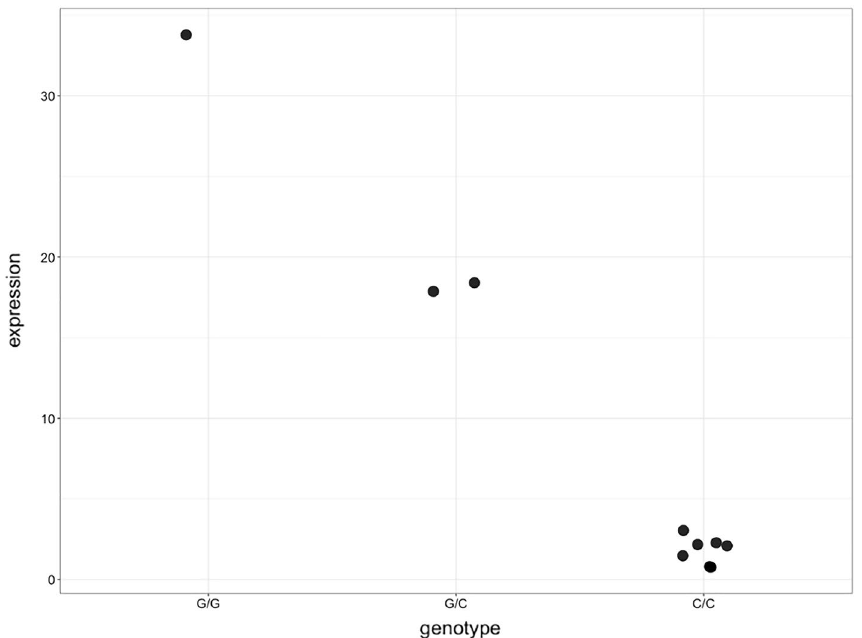
Figure 2. Differential expression of the different genotype classes detected for the cis- eQTL NC_012015.3_22440993_17257909 associated with